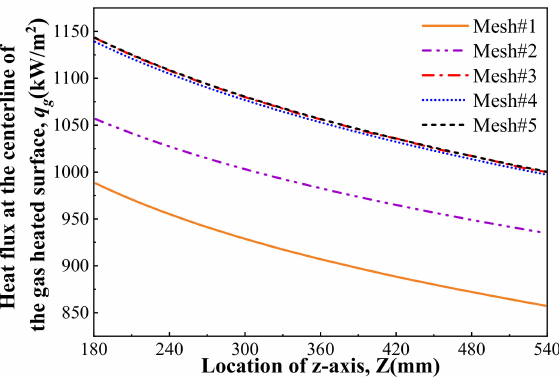
Figure 8. Variation of q g at the centerline of the gas heated surface for mesh sensitivity test in Case#1.